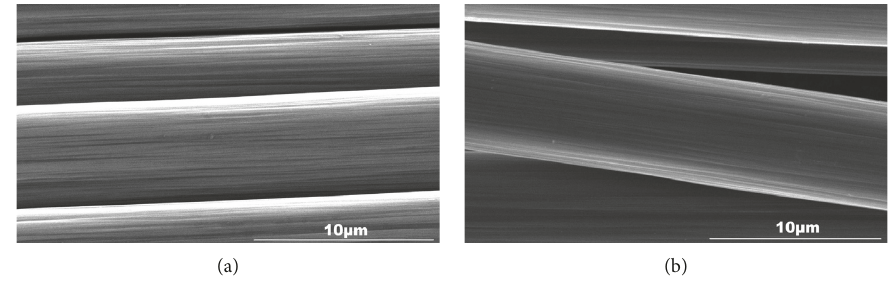
Figure 3: ESEM images of VF (a) and RF500 (b) fibres (